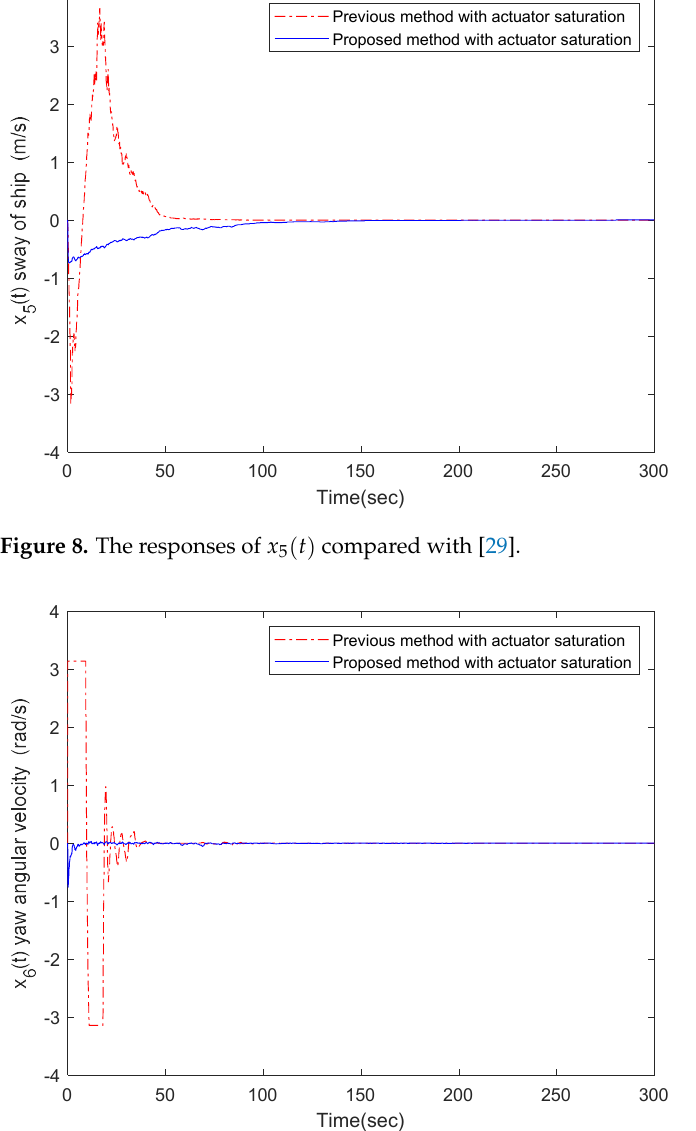
Figure 9. The responses of  